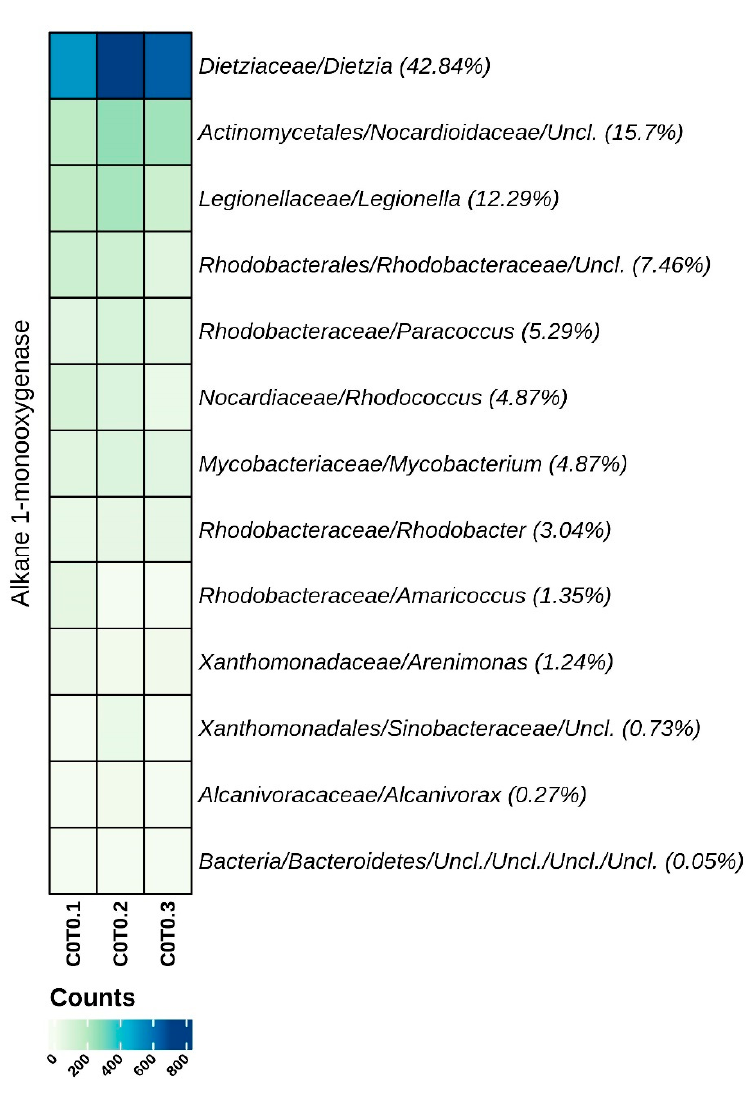
Figure 3. Functional Heatmaps of the Alkane 1-monooxygenase contribution by identified ASVs aggregated at the Genus level, as inferred by PICRUSt2 in the three biological replicates. On rows, the nearest identified taxonomic level for each contributing ASV is reported, followed by its relative percentage contribution to the functional feature. Hierarchical clustering of columns was performed by Pearson correlation, based on Euclidean distance.